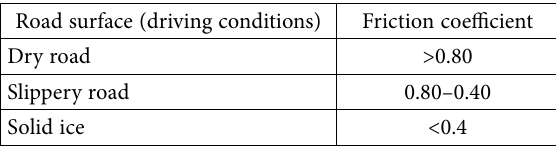
Table 2. Friction